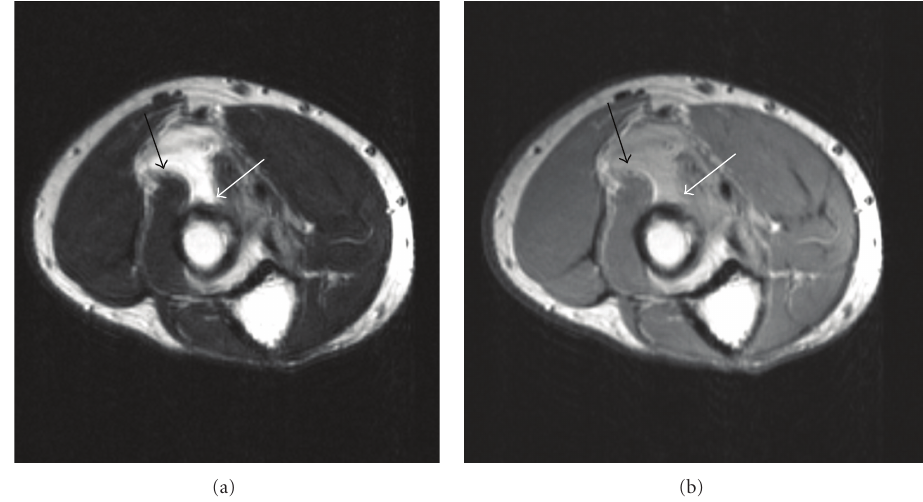
Figure 3: Axial T2 (a) and intermediate weighted (b) axial images at a slightly more distal level demonstrating partial tearing of the supinator muscle which appears to be peeled back o ff its medial attachment (solid white arrow) with the torn-free edge displaced anterolaterally (solid black